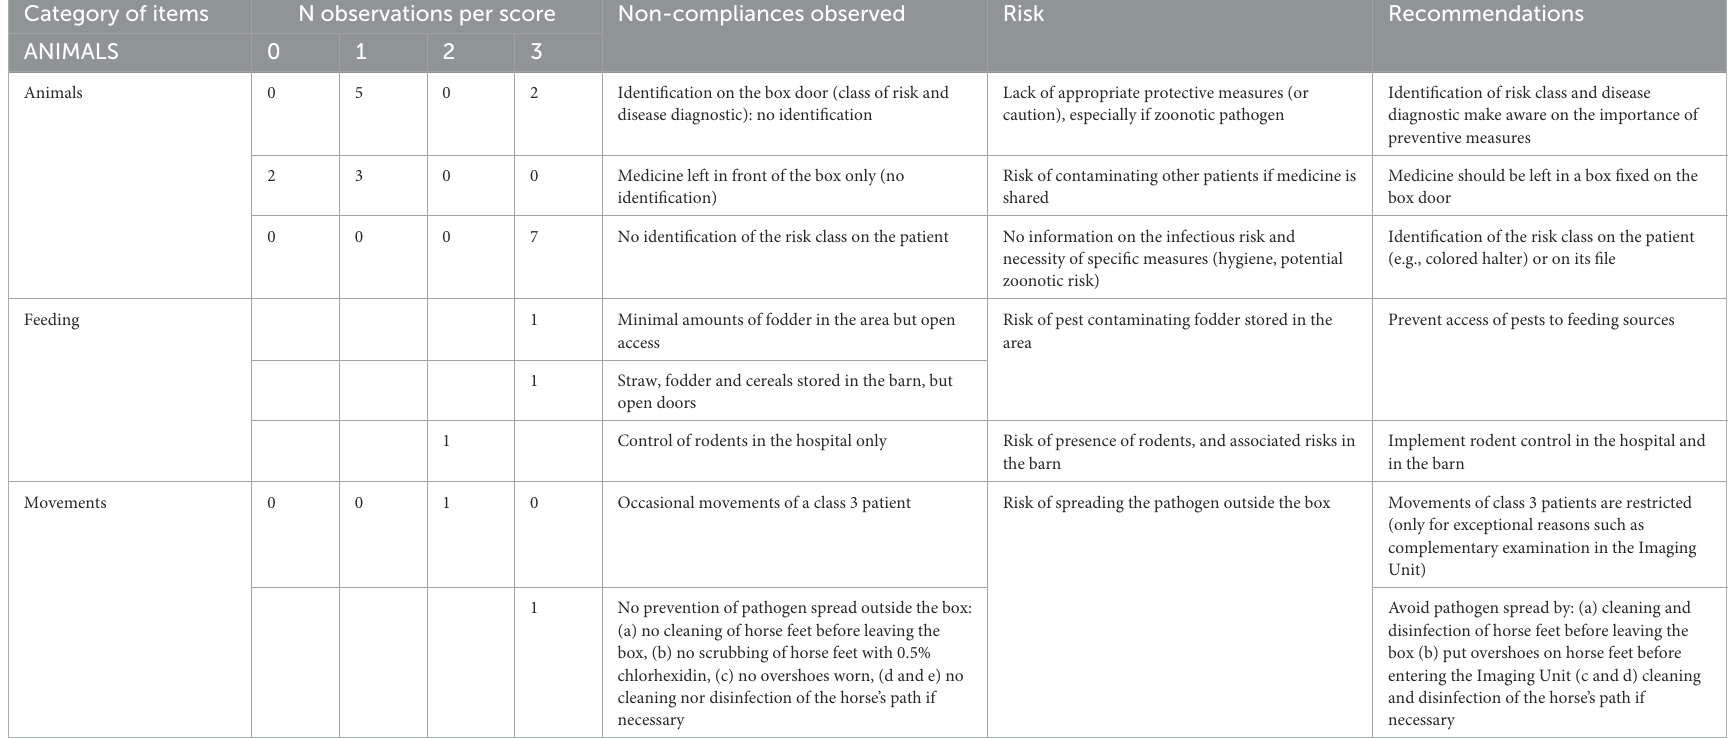
TABLE 2C Biosecurity deficiencies observed when performing the internal audit in the Equine class 3 area—category “ANIMALS”. Category of